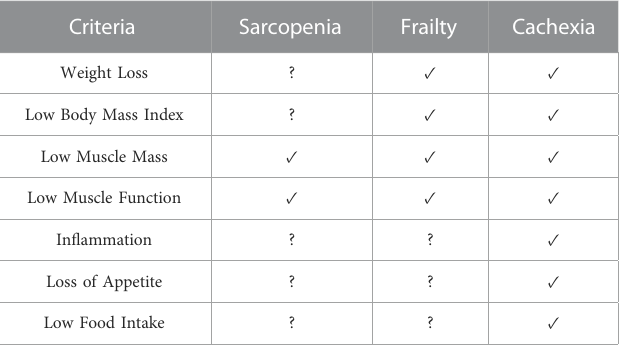
TABLE 1 Similarities and differences in sarcopenia, frailty, and cachexia. ✓ = usually present, ? = not necessarily present. Adapted from (Prado et al., 2021).